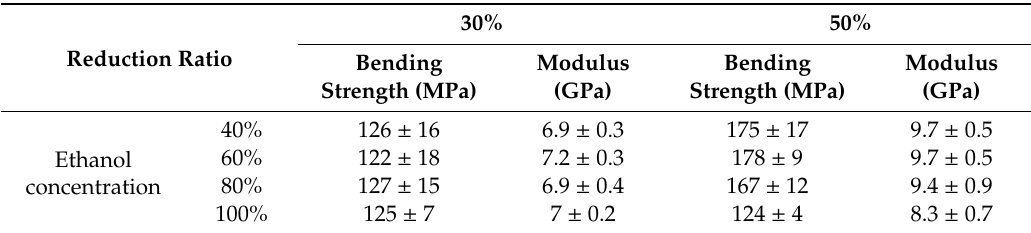
Table 3. Mechanical properties of hot-rolled RS resin with di ff erent ethanol concentration treatment and reduction ratios (30%,